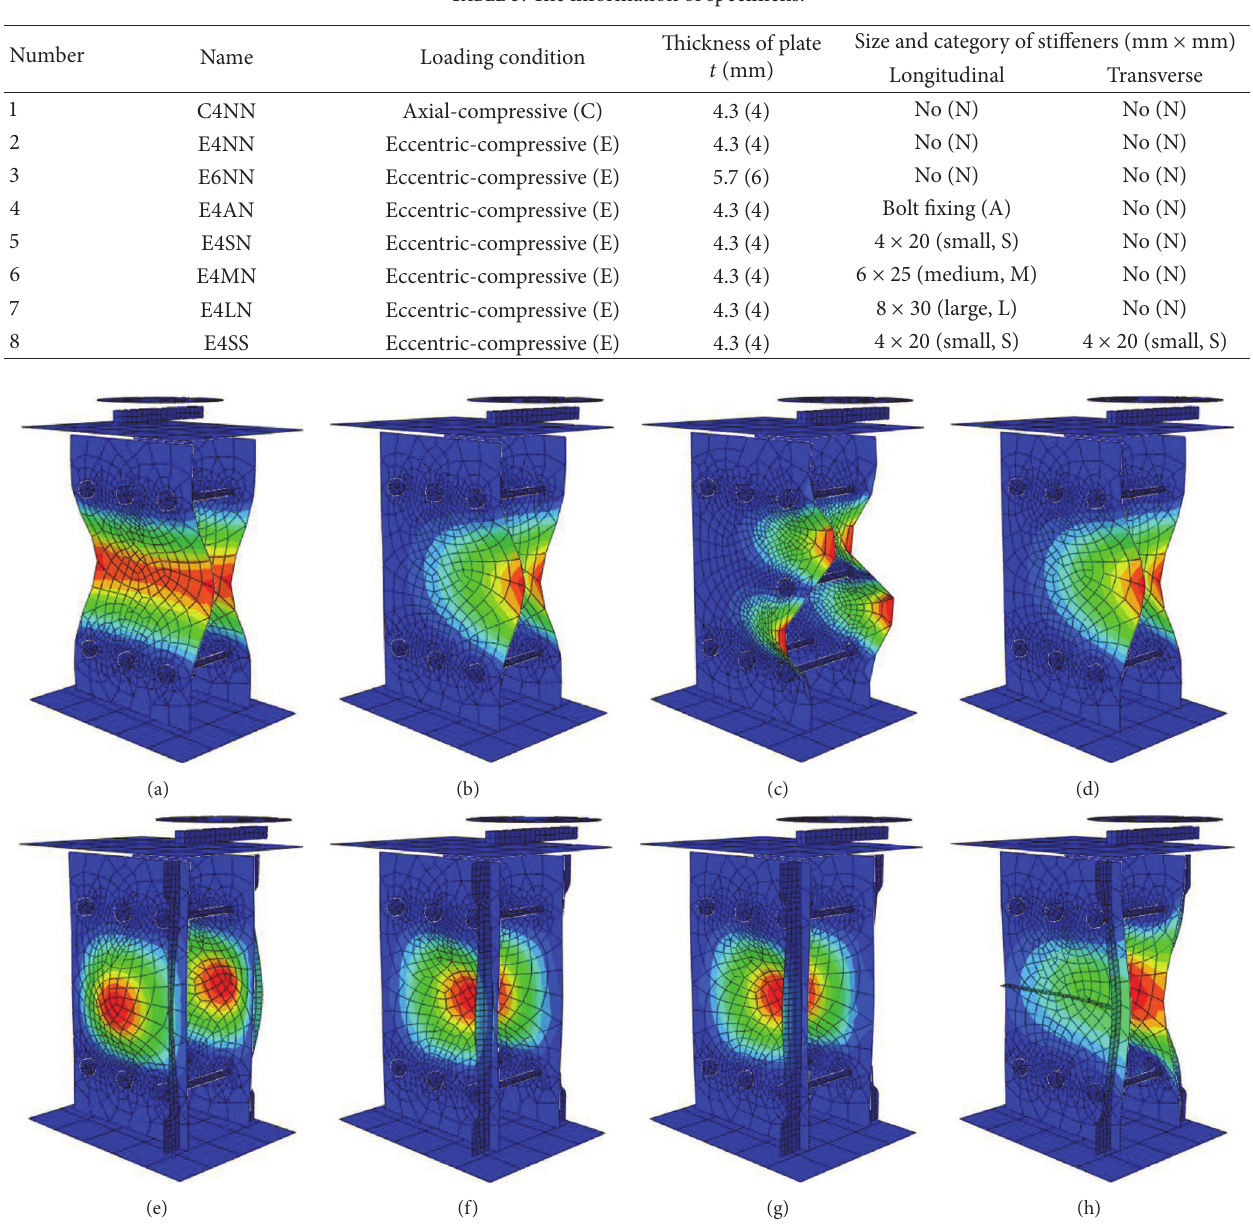
Figure 3: Buckling modes of each of the specimens (a) C4NN, (b) E4NN, (c) E4AN, (d) E6NN, (e) E4SN, (f) E4MN, (g) E4LN, and (h)